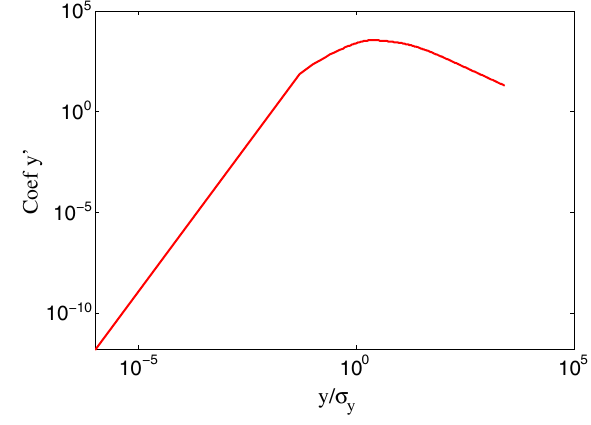
FIG. 4. The integral term in Eq. (18) as a function of y = σ y .